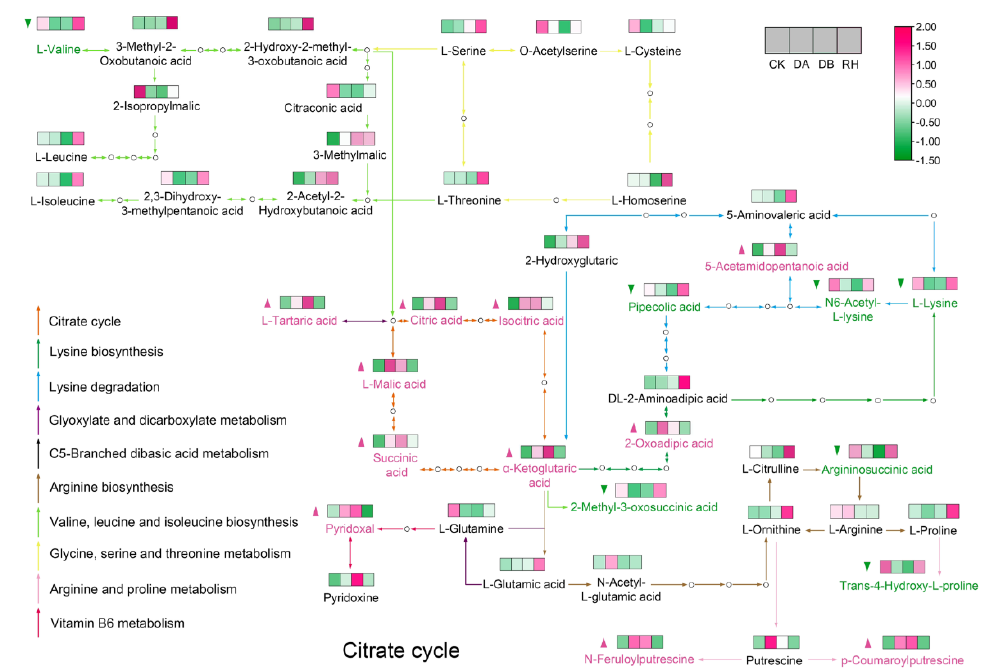
Figure 7. Comparative analysis of metabolites involved in amino acid pathways and the tricarboxylic acid cycle (TCA) among the control (CK), 15-day drought treatment (DA), 30-day drought treatment (DB), and rehydration (RH) groups. The contents of compounds in CK, DA, DB, and RH detected by GC-MS analysis are represented in the heatmaps, whereas those shown as circles were undetectable. The regular triangles in red and inverted triangles in green above the heatmaps indicate the metabolites that were upregulated and downregulated, respectively, in DA and DB. The different coloured arrows between metabolites represent the different pathways, to which the metabolites belonged.